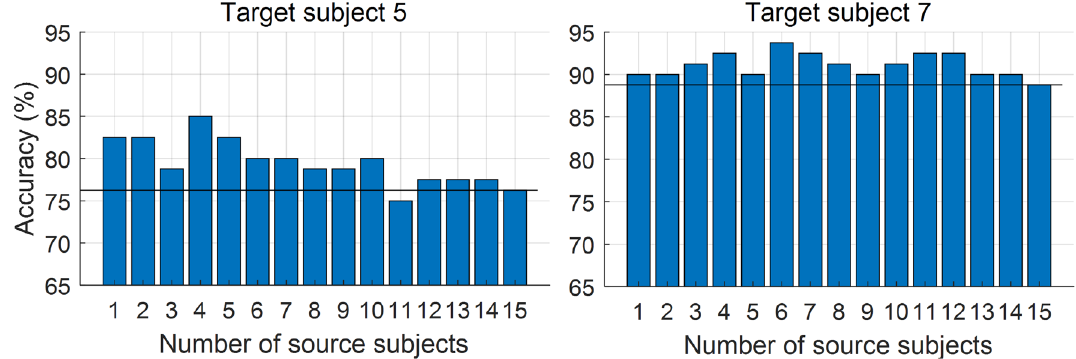
Figure 7. The classification accuracies of the two target subjects (#5 and #7) change with the number of chosen source subjects. The solid line in each subplot denotes the accuracy of SSL (baseline) algorithm for comparison.